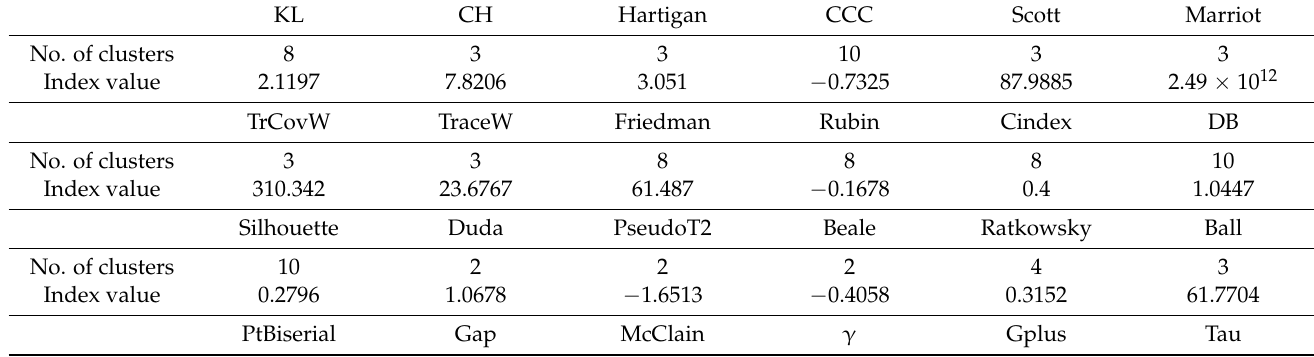
Table 5. List of the best number of clusters and their index value of 30 indices implemented in the NbClust package in R.